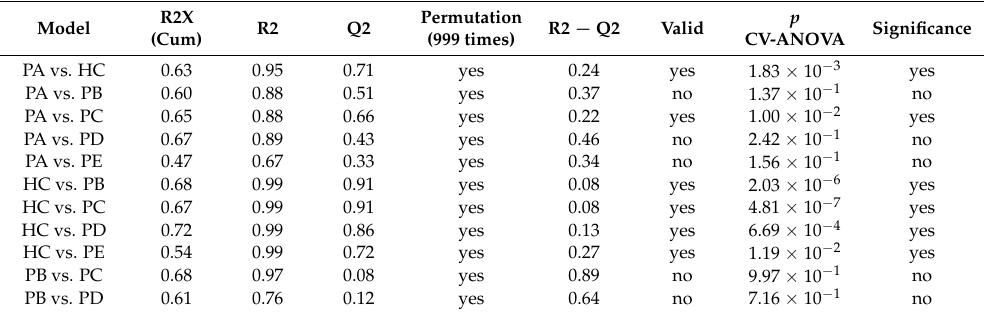
Table 1. An overview of all the orthogonal partial least square-discriminant analysis (OPLS-DA) parameters and their validity. The p CV-ANOVA column denotes the p value associated with the cross-validation analysis of variance